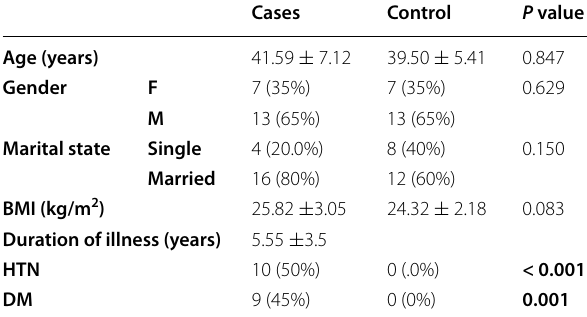
Table 1 Socio-demographic characteristics of cases and controls